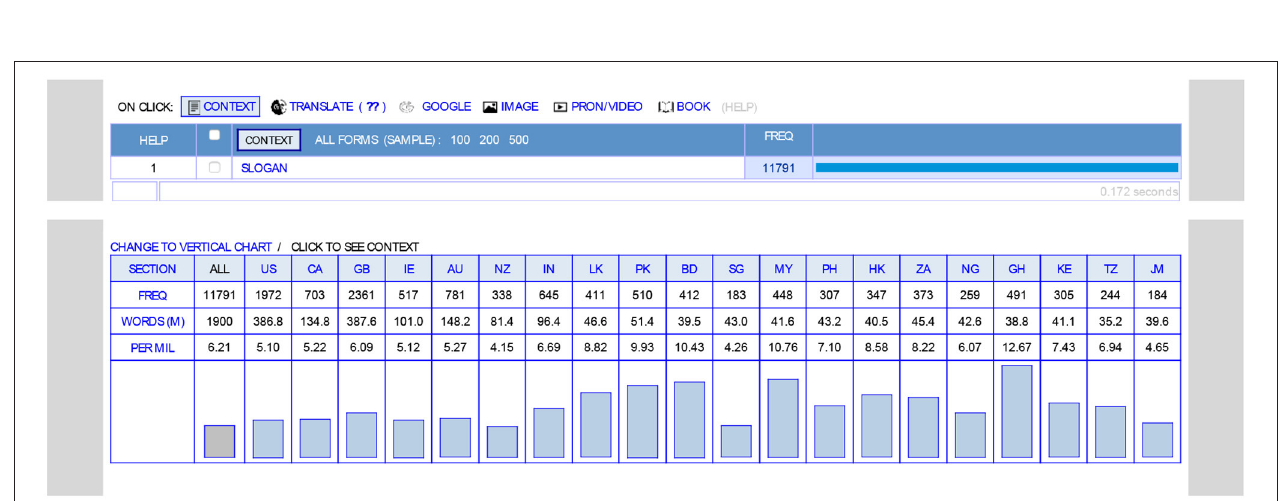
FIGURE 13 | Distribution of slew in the GloWbE Corpus (from https://www.english-corpora.org/glowbe/).